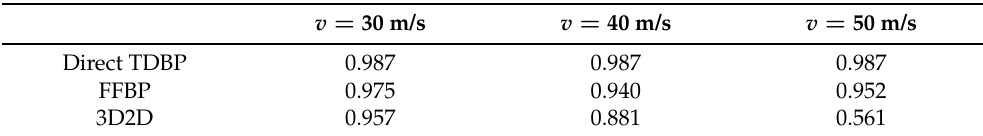
Figure 12. IRF with different aperture size. (First row) A s = 1.06 m. (Second row) A s = 1.45 m. (Third row) A s = 1.82m. All the IRF are focused on using a cubic interpolator. Table 2. Normalized peak values of the IRF for different velocities (aperture length) and for different focusing